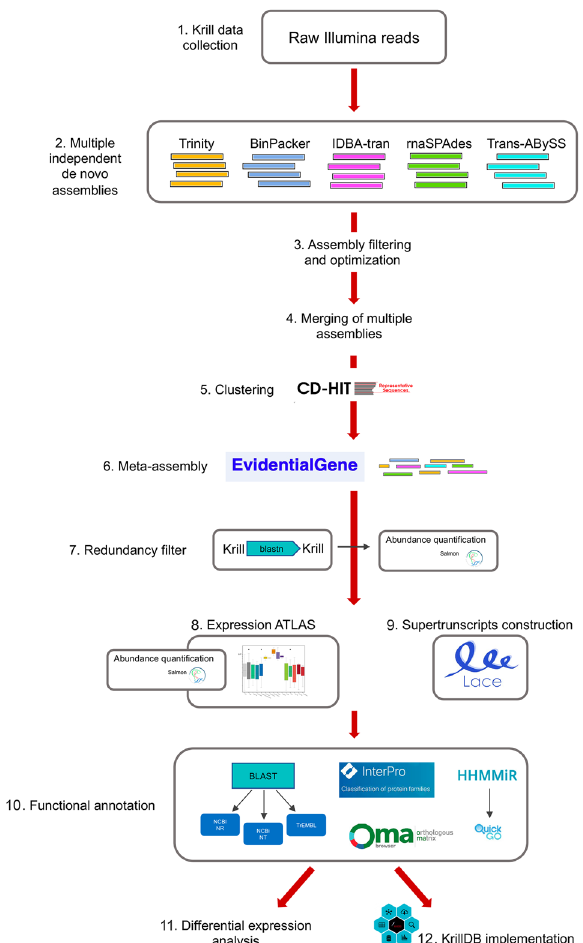
Figure 7. Workflow of the assembly process, annotation, database re-design and downstream